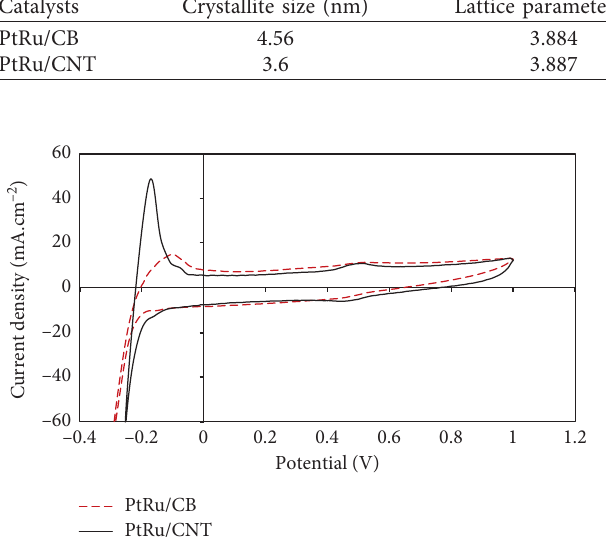
Figure 6: Cyclic voltammetry test of synthesized Table 2: Comparison of the electrocatalytic activity, current density, and catalytic resistance.